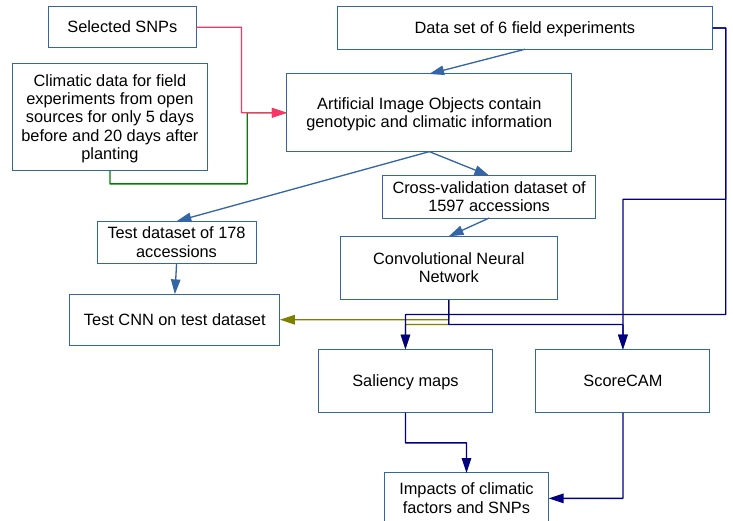
Figure 1. The overview of the research. The datasets, performed numerical experiments, and results are shown as boxes on the diagram, while the arrows represent the data flow. These steps are described